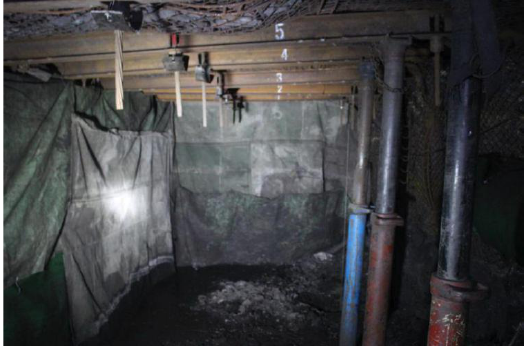
Figure 13. Field effect drawing of air blocking at the initial position of roadway forming.